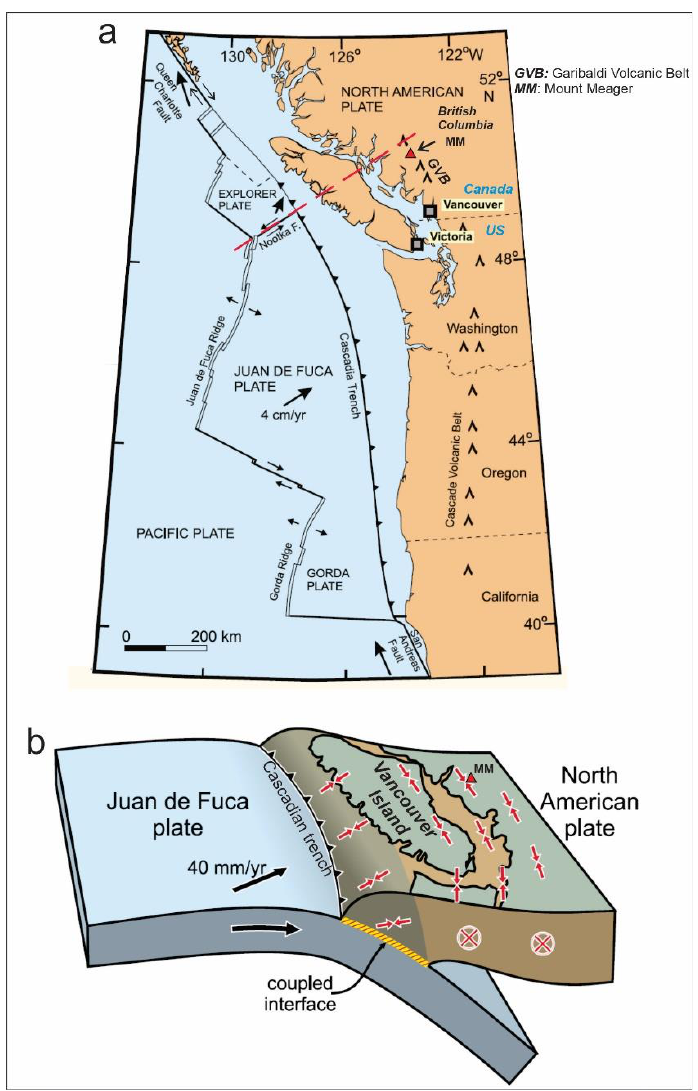
Figure 1. Diagrams showing the plate tectonic background and regional characteristics of the stress field of the Cascades Volcanic Arc in the North American Plate. ( a ) Map showing tectonic setting of the study area (figure modified from [24]), and ( b ) cartoon showing the dominant stress orientations (red arrows) in southwest British Columbia. The red crosses in circles indicate motion into the page due to the northward push of the Oregon Block (figure modified from [23]).